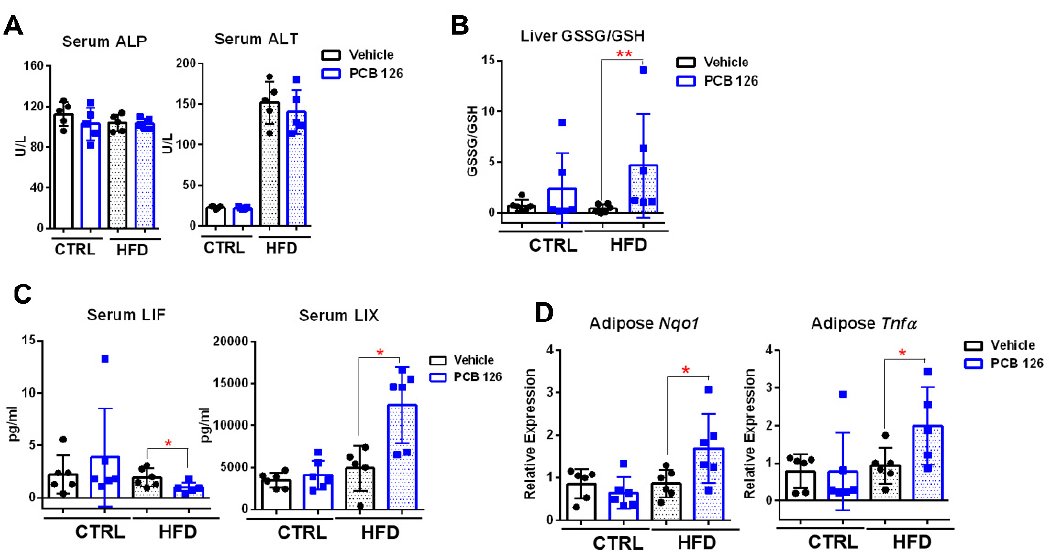
Figure 2. Effects of early life PCB 126 on inflammatory indicators in mice with CTRL or HFD. ( A ) Serum concentrations of alanine transaminase (ALT) and alkaline phosphatase (ALP) from CTRL or HFD ‐ fed mice with vehicle or PCB 126 exposure. ( B ) Ratio of oxidized glutathione (GSSG) to reduced glutathione (GSH) in the liver from CTRL or HFD ‐ fed mice with vehicle or PCB 126 expo ‐ sure. ( C ) Serum cytokines, including leukemia inhibitory factor (LIF) and lipopolysaccharide ‐ in ‐ duced CXC chemokine (LIX), from CTRL or HFD ‐ fed mice with vehicle or PCB 126 exposure. ( D ) qPCR analysis of mRNA levels of inflammatory cytokines in the adipose from CTRL or HFD ‐ fed mice with vehicle or PCB 126 exposure. Values are means ± S.D. (n = 6 per group). * p < 0.05, ** p < 0.01 compared to vehicle. 3.3. Early Life PCB 126 Exposure Does Not Worsen the Effects of HFD Related to Adiposity in Adulthood Oil red O staining of the liver showed no obvious changes, such as increased lipid accumulation and droplet size, in both CTRL and HFD ‐ fed mice in adulthood with PCB 126 exposure (Figure 3A). Consistently, the quantitative 1 H NMR analysis and triglyceride assay kit showed no significant changes in hepatic lipids, including fatty acids, in CTRL or HFD ‐ fed mice in adulthood with early life PCB 126 exposure (Figure 3B–D). Consistent with the metabolomics data, no significant changes in the mRNA expression of genes in ‐ volved in de novo fatty acid biosynthesis were observed in the liver from CTRL or HFD ‐ fed mice with PCB 126 exposure (Figure 3E).